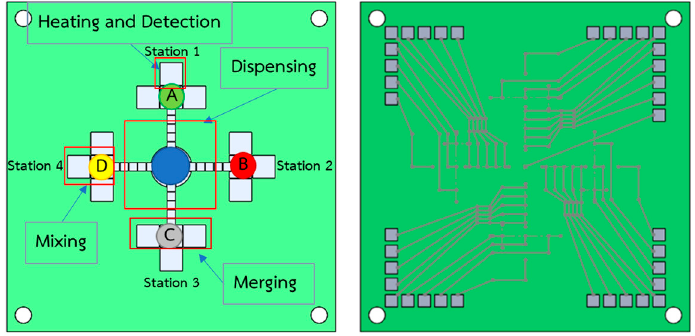
Figure 7. The bottom electrode layout design of the LAMP–XO EWOD